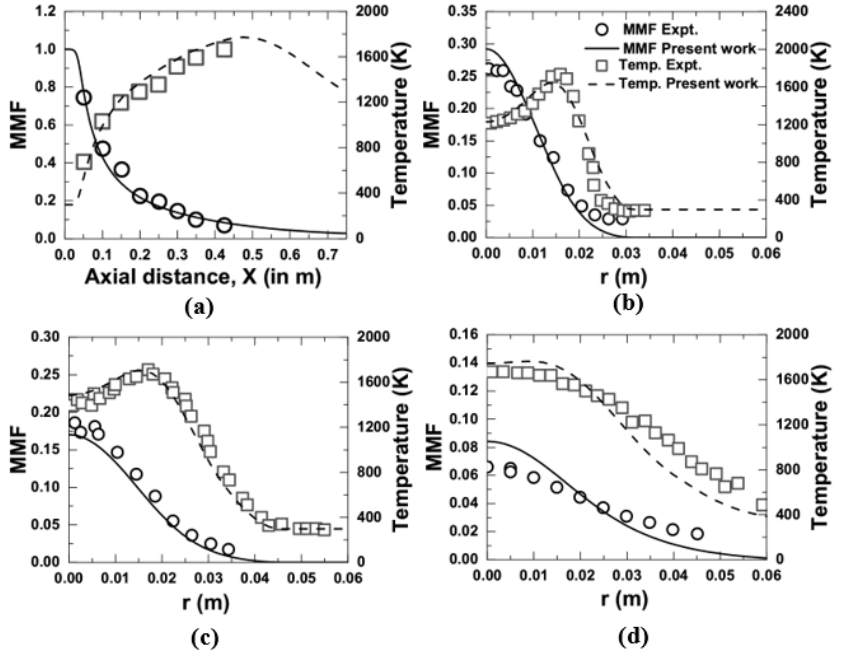
Figure 3. Comparison of temperature and mean mixture fraction (MMF) obtained from the present numerical model with the measurements [10] at 1 atm; ( a ) axial variation, and ( b – d ) radial variation at an axial location of 0.15 m, 0.35 m, and 0.425 m, respectively.